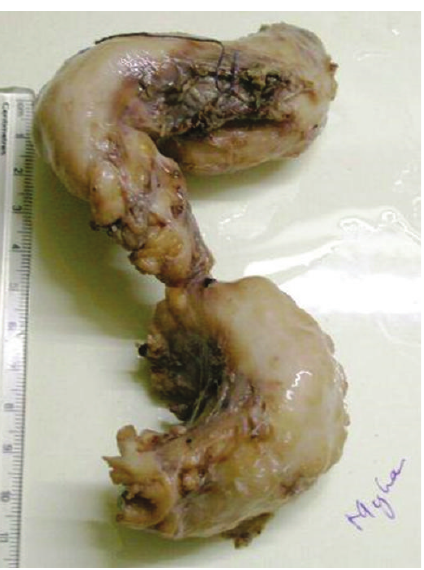
Figure 8: Excised specimen of esophageal leiomyoma sent for HPE after fixation, measuring approximately 16 × 4 × 3